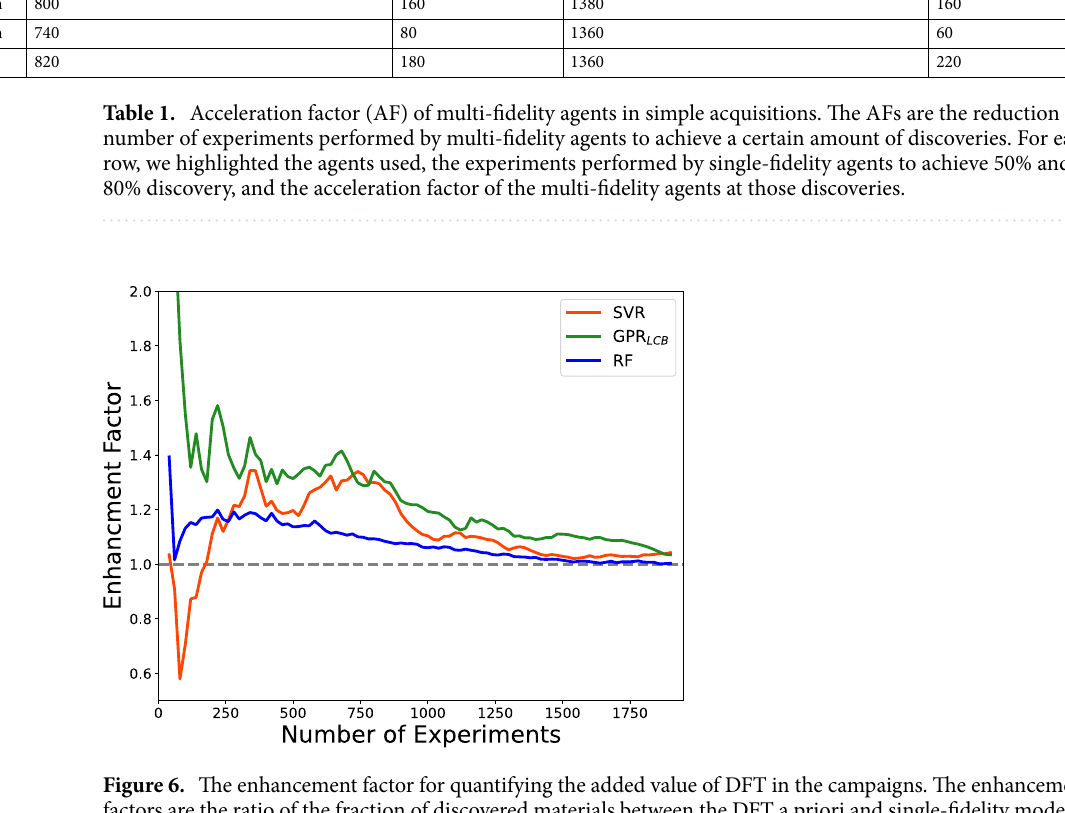
Figure 6. The enhancement factor for quantifying the added value of DFT in the campaigns. The enhancement factors are the ratio of the fraction of discovered materials between the DFT a priori and single-fidelity models at any given